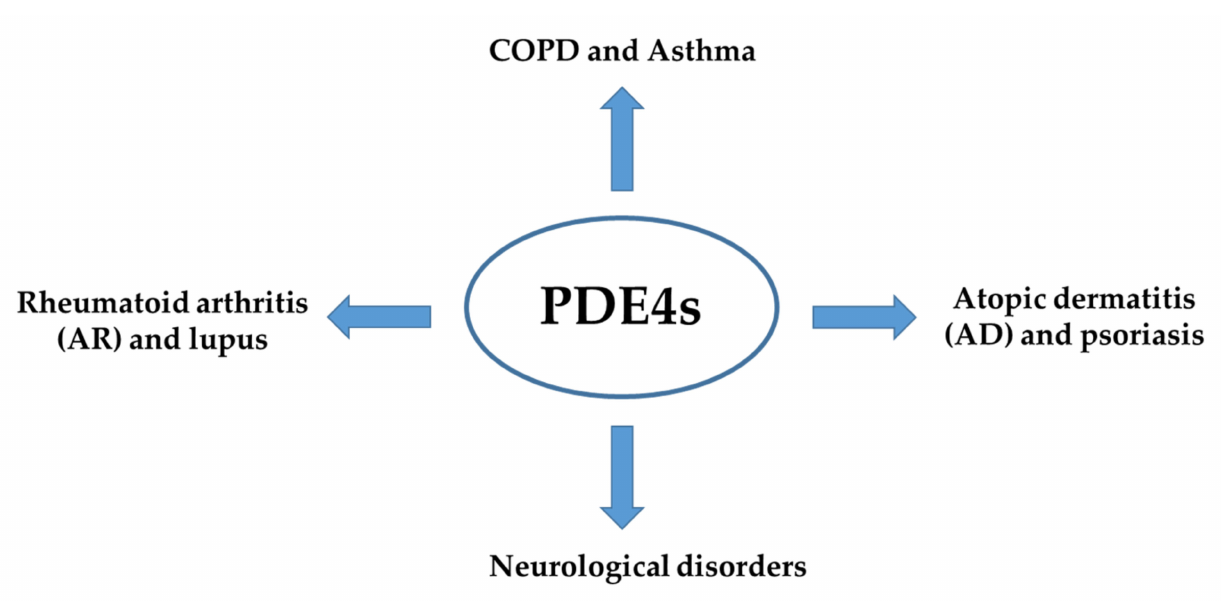
Figure 2. PDE4s involvement in the physio-pathogenesis of inflammatory